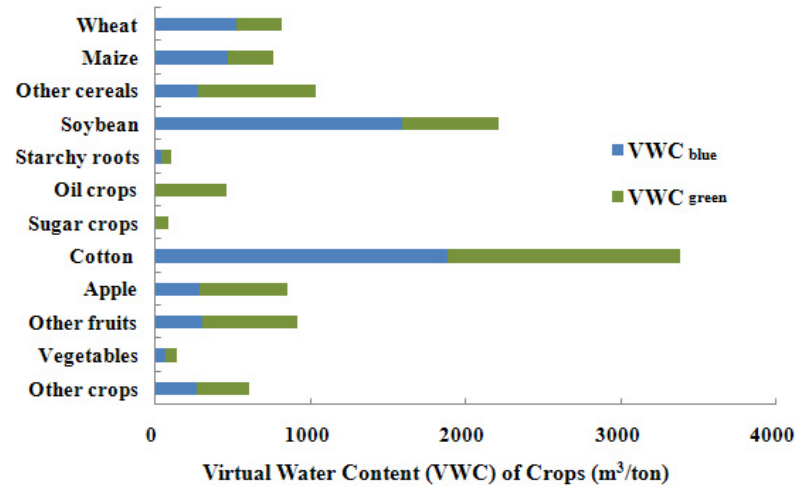
Fig. 3. Blue and green virtual water content (VWC) of crops within the HRB.